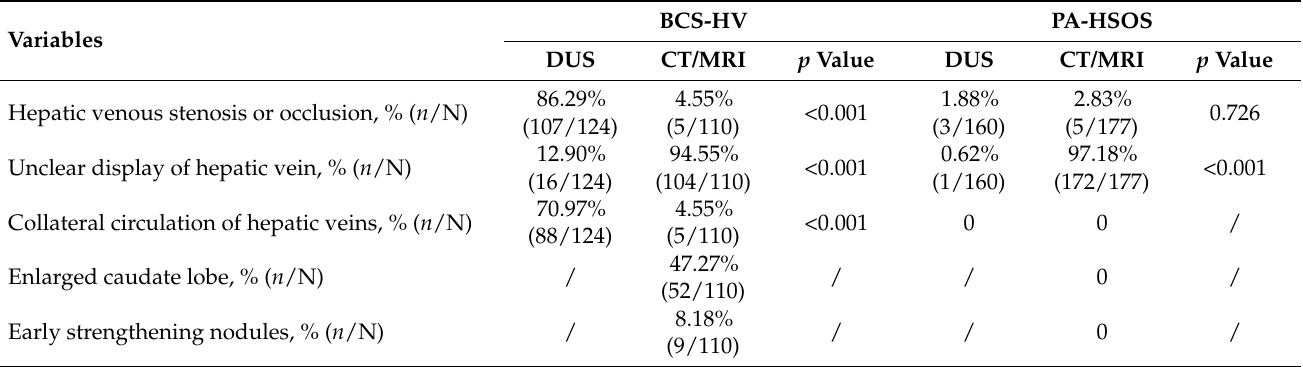
Table 4. Comparison of color Doppler ultrasound and enhanced CT in BCS-HV and